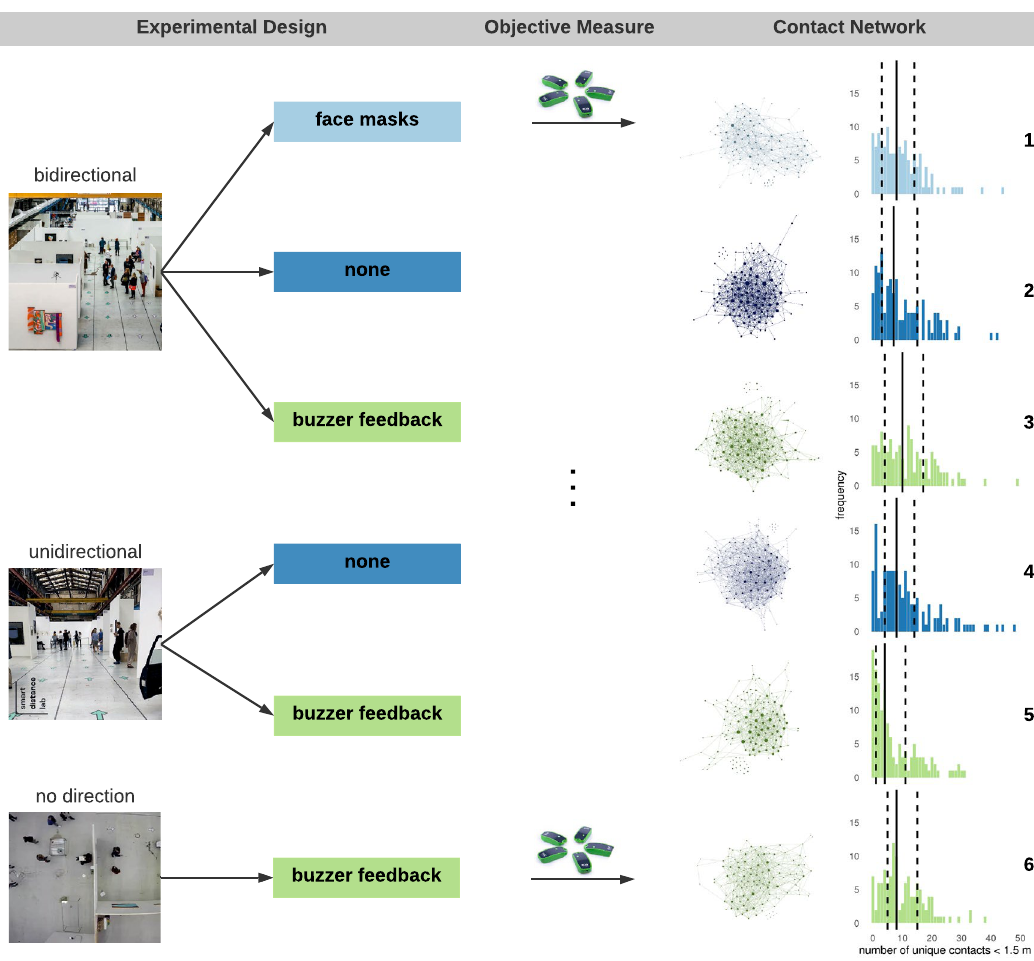
Figure 1. Representation and application of the novel methodological framework. The framework consists of (1) an experimental design; (2) objective physical distance measures; and (3) a contact network representation. Here, we show the framework applied at the art fair, where we (1) varied walking directions and supplementary interventions; (2) measured physical distance using a Social Distancing Sensor with ultra-wideband technology; and (3) constructed networks for each condition.